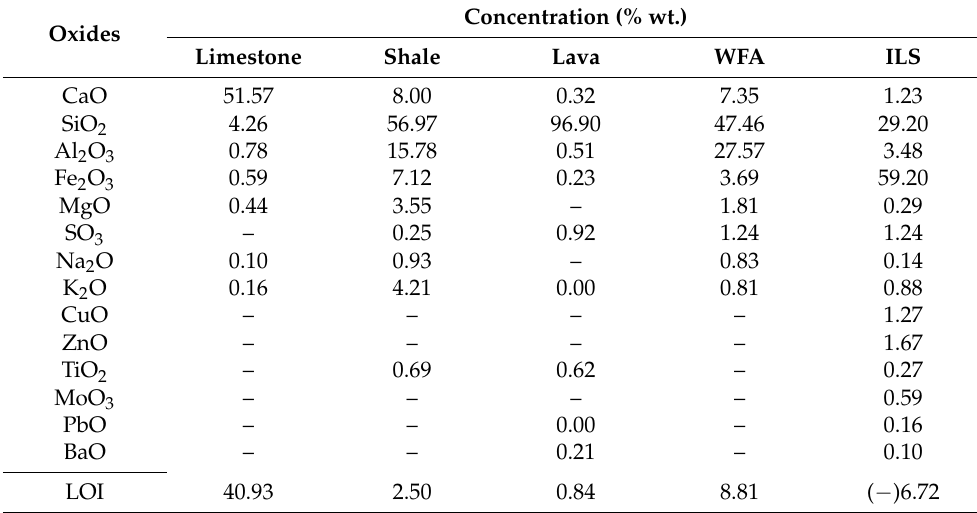
Table 1. XRF analysis and LOI of raw materials.